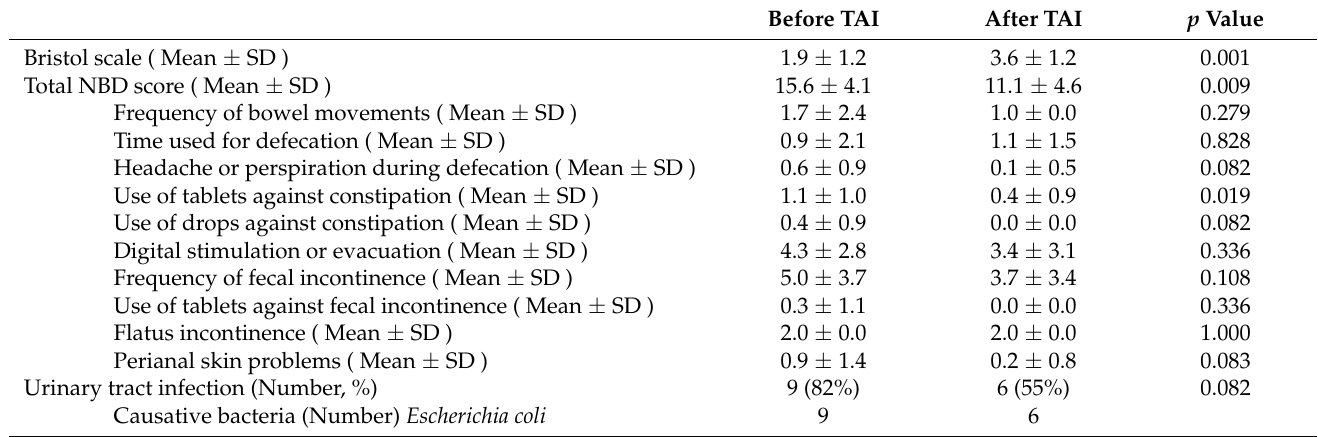
Table 3. Influence of transanal irrigation (TAI) on outcome measures. Before TAI After TAI p